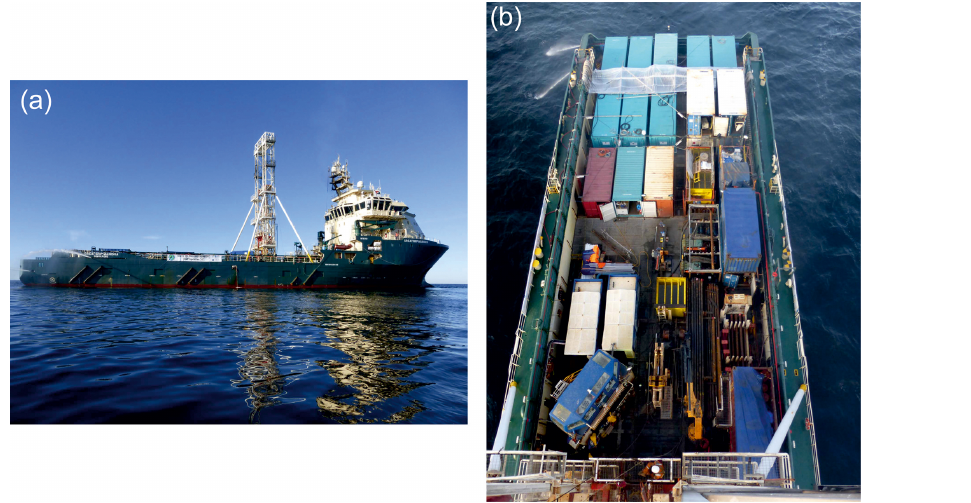
Figure 3. (a) The geotechnical vessel, Greatship Manisha (of Singapore) equipped with a drilling derrick. (b) View from the derrick over the drill deck at mid-ship and the “science garden” to the aft. Image copyright